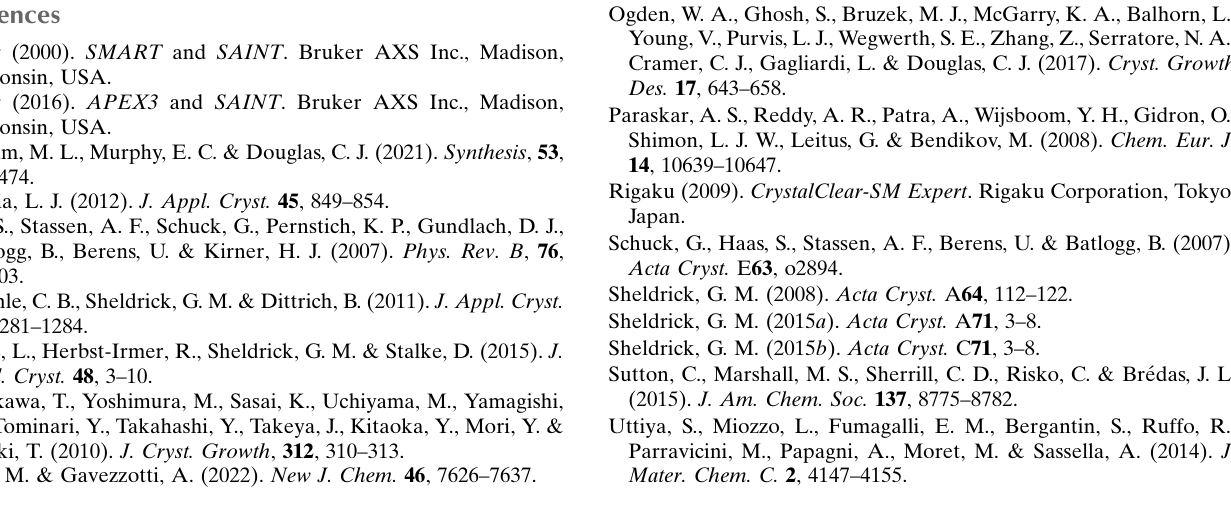
Crystal data Chemical